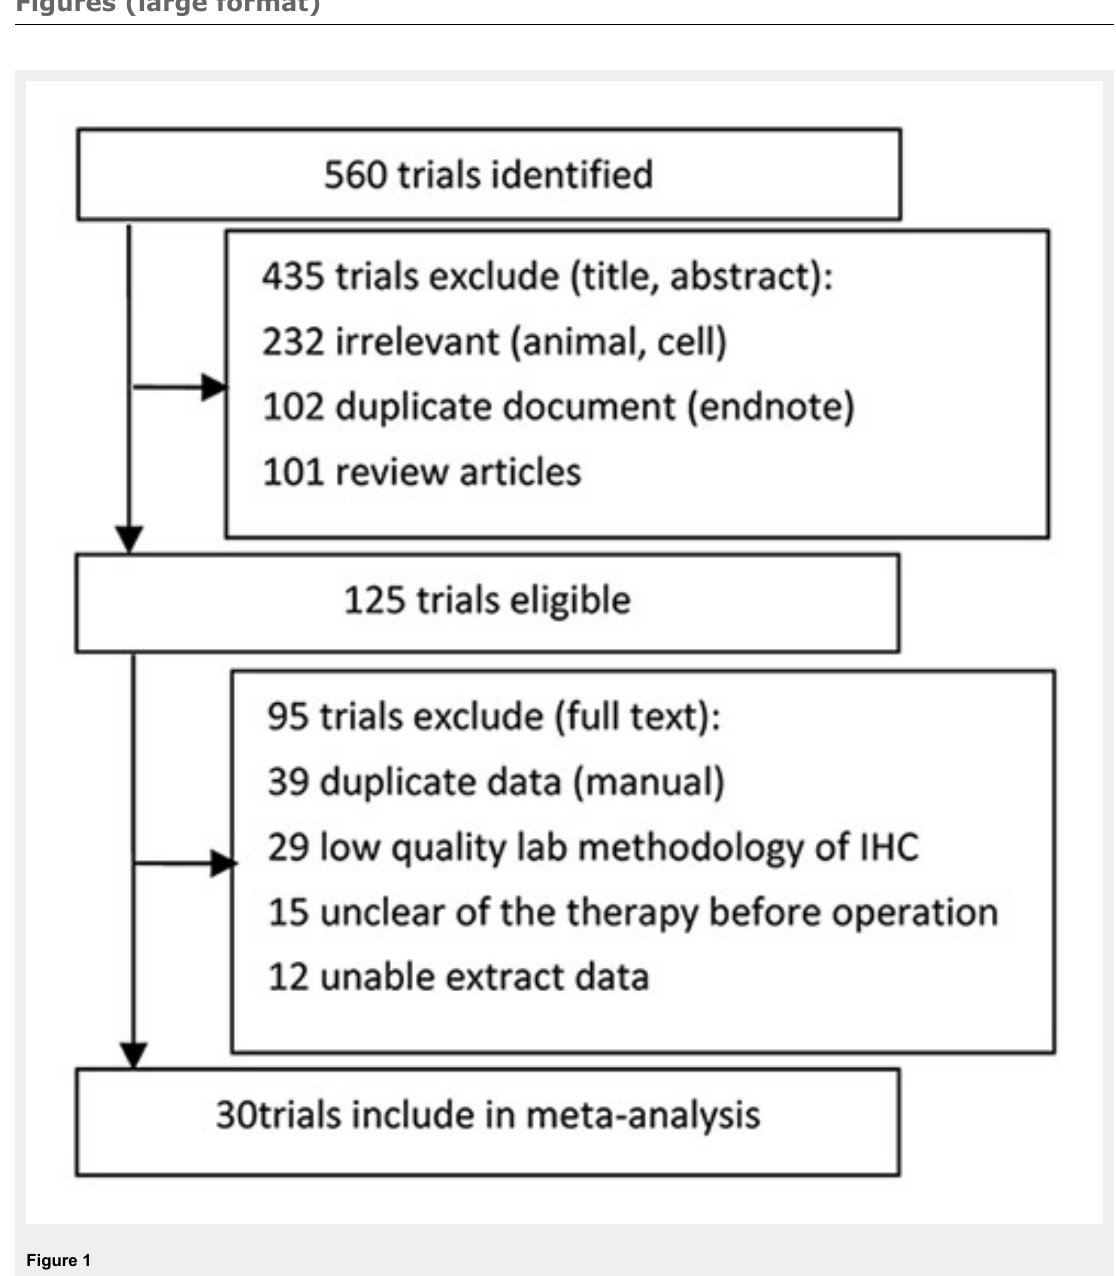
Figure 1 Flow chart of article selection in the systematic review and